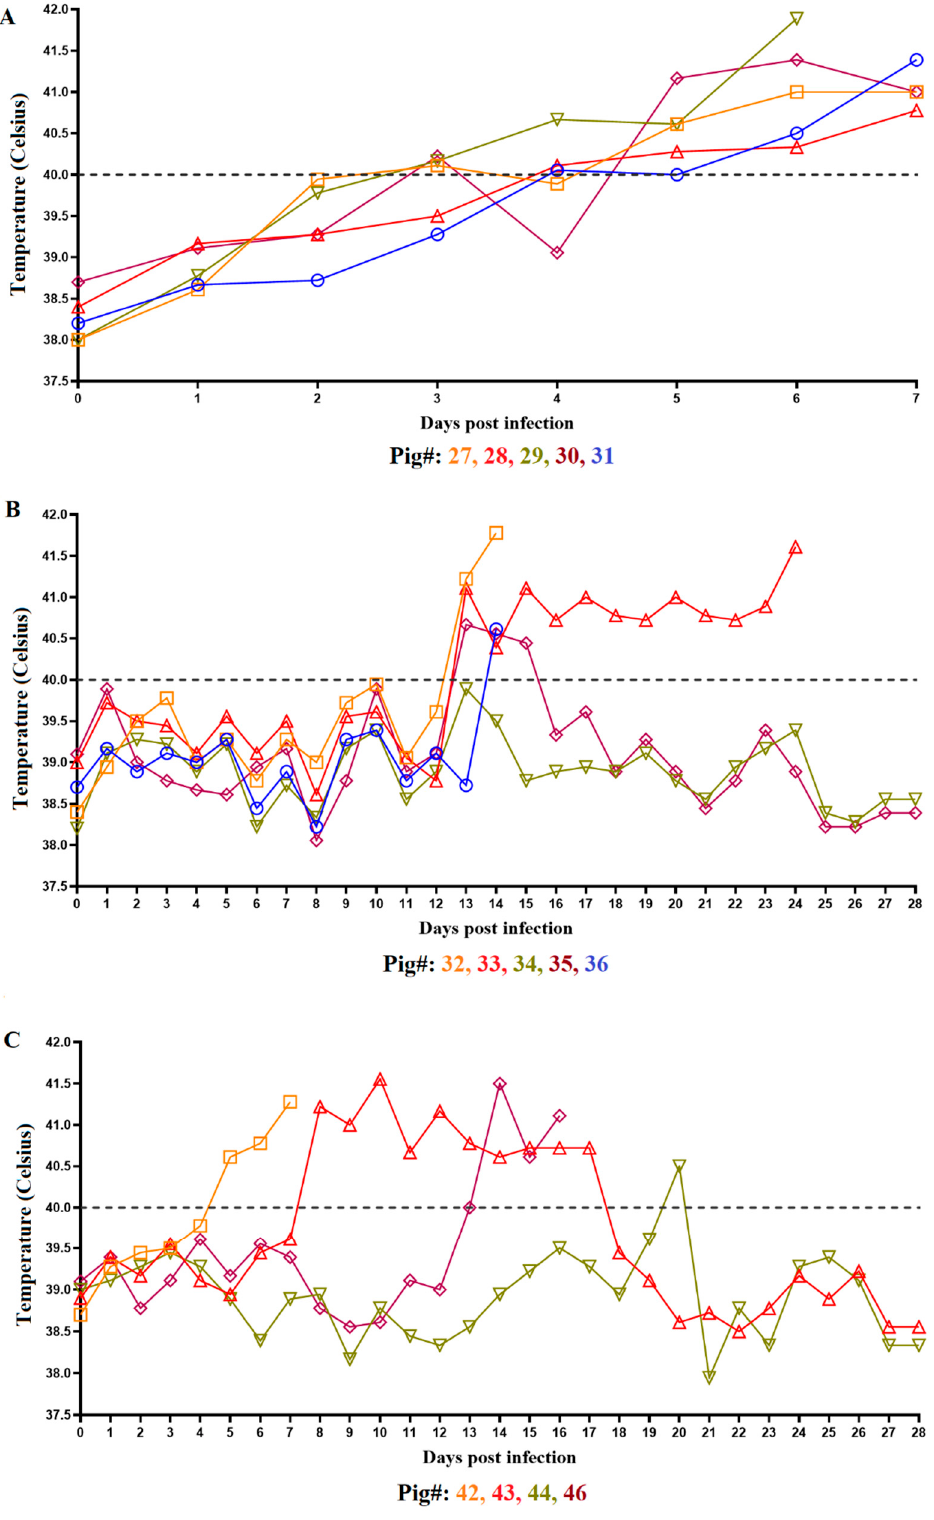
Figure 1. Body temperature measurements from animals inoculated with ASFV-DR21 IM ( A ), by contact ( B ), or ON ( C ) from day 1–28 pi. Data are presented as individual values (expressed as ◦ C), with different colored lines and symbols representing individual animals. The horizontal dashed line denotes 40 ◦ C. Animal #45 was excluded from the data presented due to removal from the study on day 0.